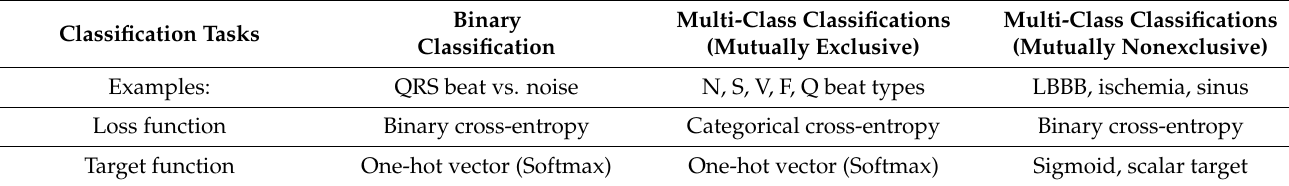
Table 1. Selection of loss function and target function for different classification tasks. Classification